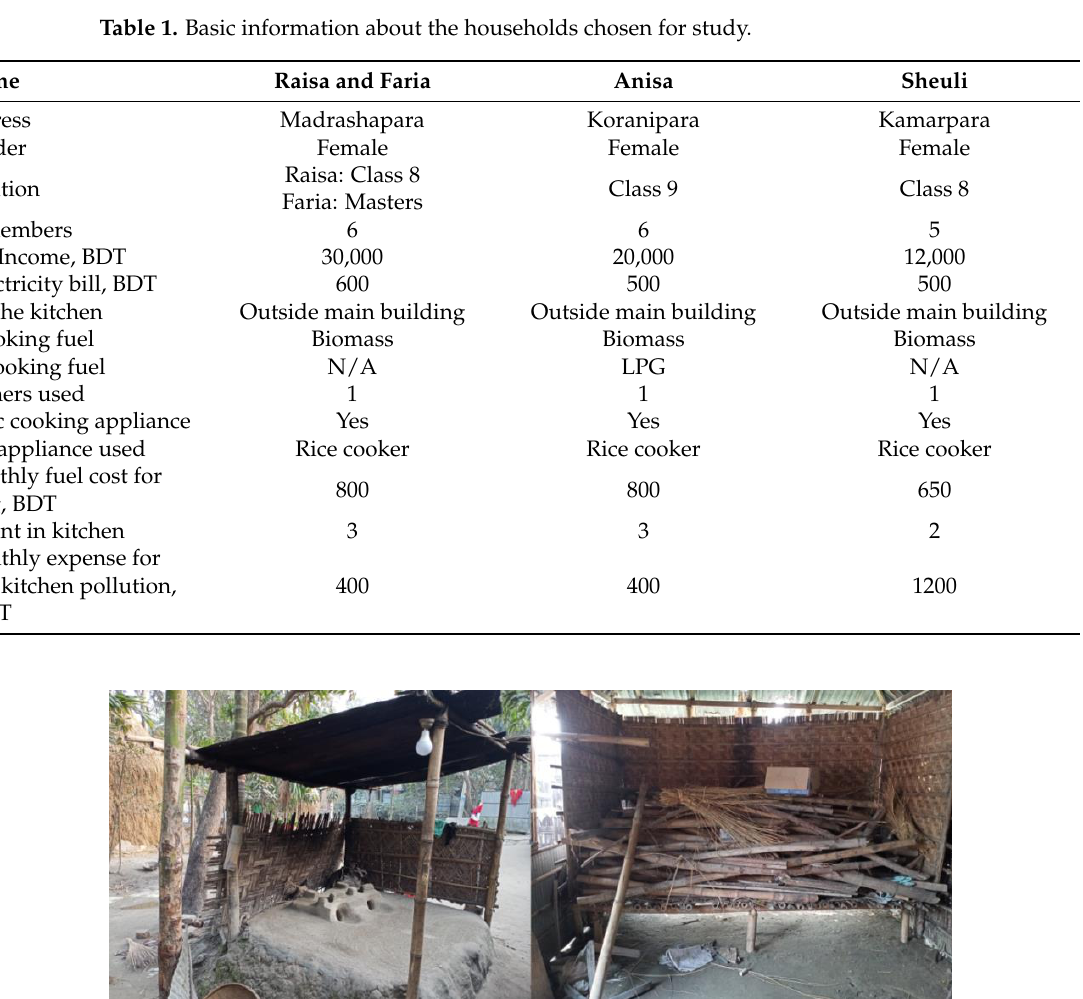
Figure 1. A typical outdoor kitchen ( left ) and firewood storage shed ( right ) at Jaldhaka,